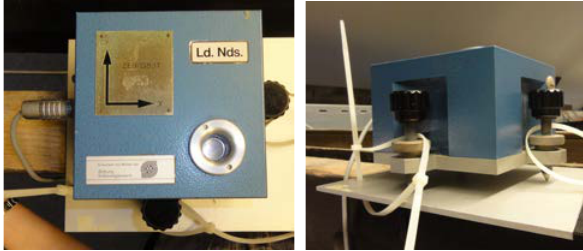
Figure 8. Top view (left) and side view (right) of the vibration sensor. The cable ties only are for security reasons.